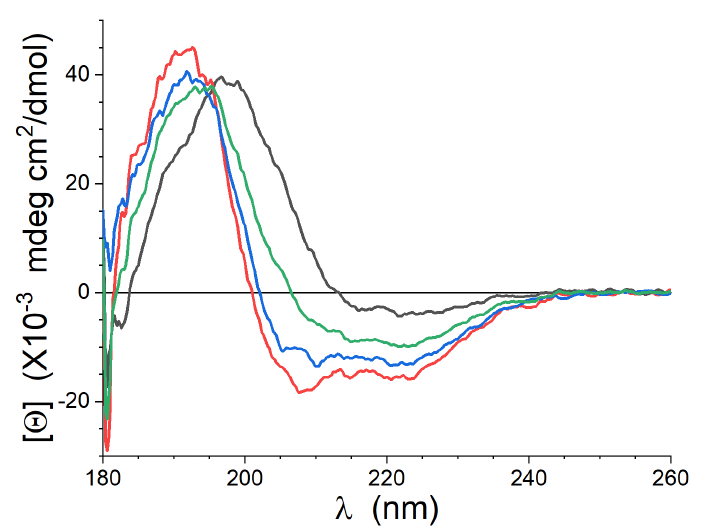
Figure 1. CD data of gp41rk in Lipid-1 (black), Lipid-2 (red) and Lipid-3 (blue) at P/L = 1/50. The green curve is an equally-weighted superposition of the Lipid-1 and Lipid-2 data (i.e.,